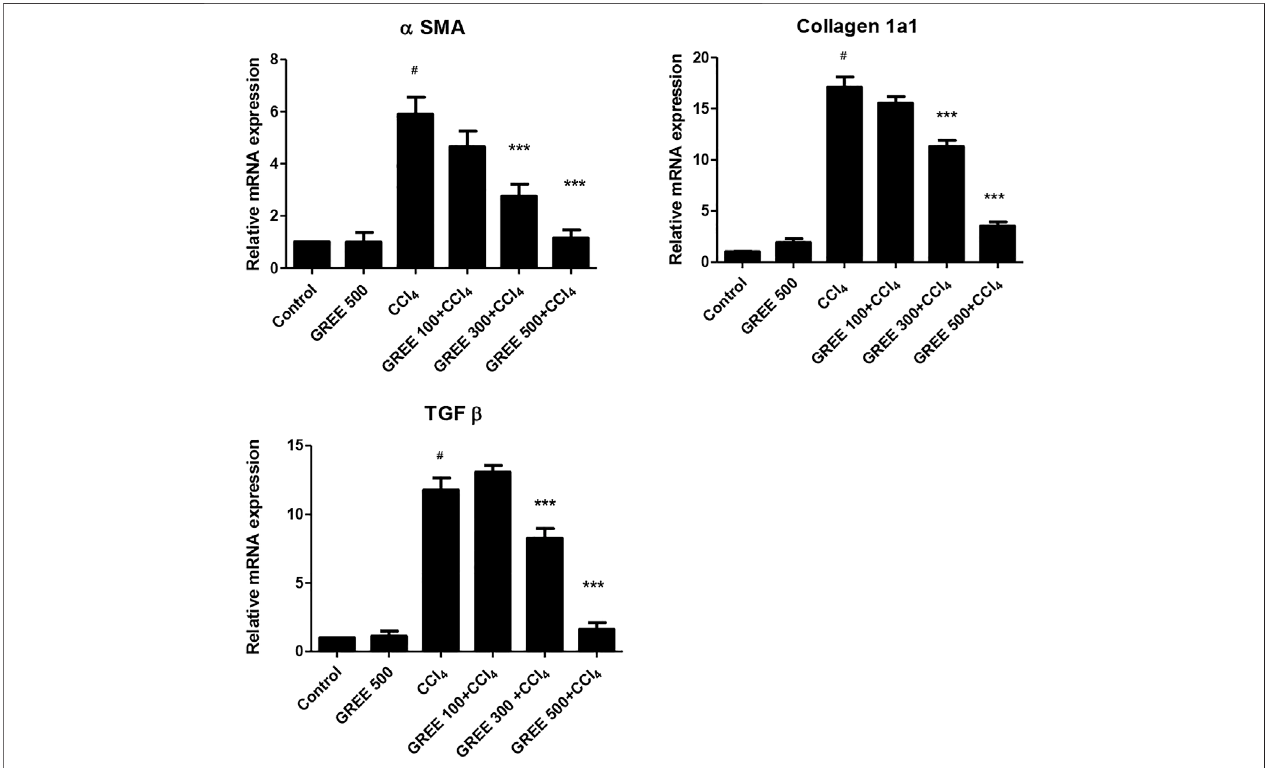
FIGURE 4 | mRNA expression in various treatment groups. The relative mRNA expression of smooth muscle actin, collagen, and TGF-beta in the liver tissues of animal from various groups was determined by real-time PCR. Values are represented as the mean ± S.D., n = 4. Signi fi cance: # p < 0.001 when compared to group A and *** p < 0.001 when compared to group